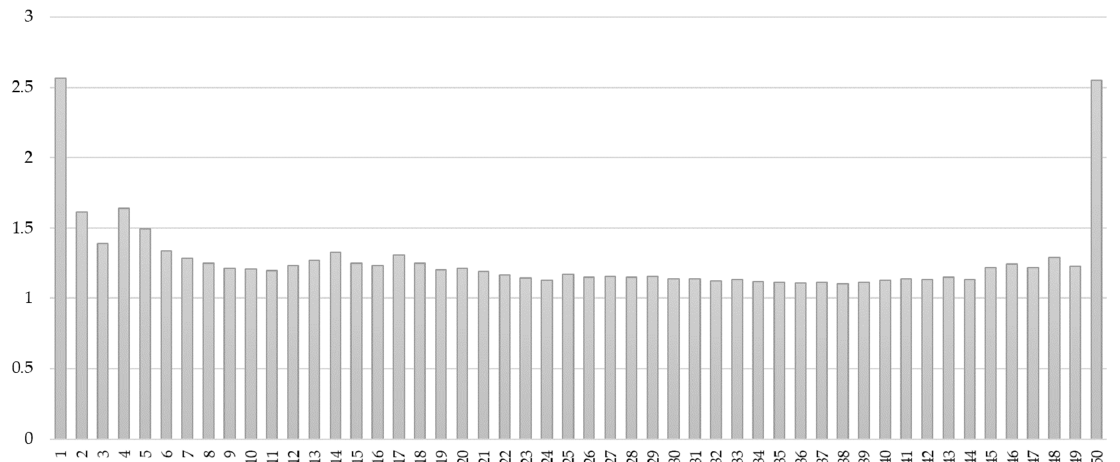
Figure A1. Coefficients quotients in one-by-one merging steps of clustering (including boot capacity, without price variable). Table A1. List of cars assigned to particular groups.